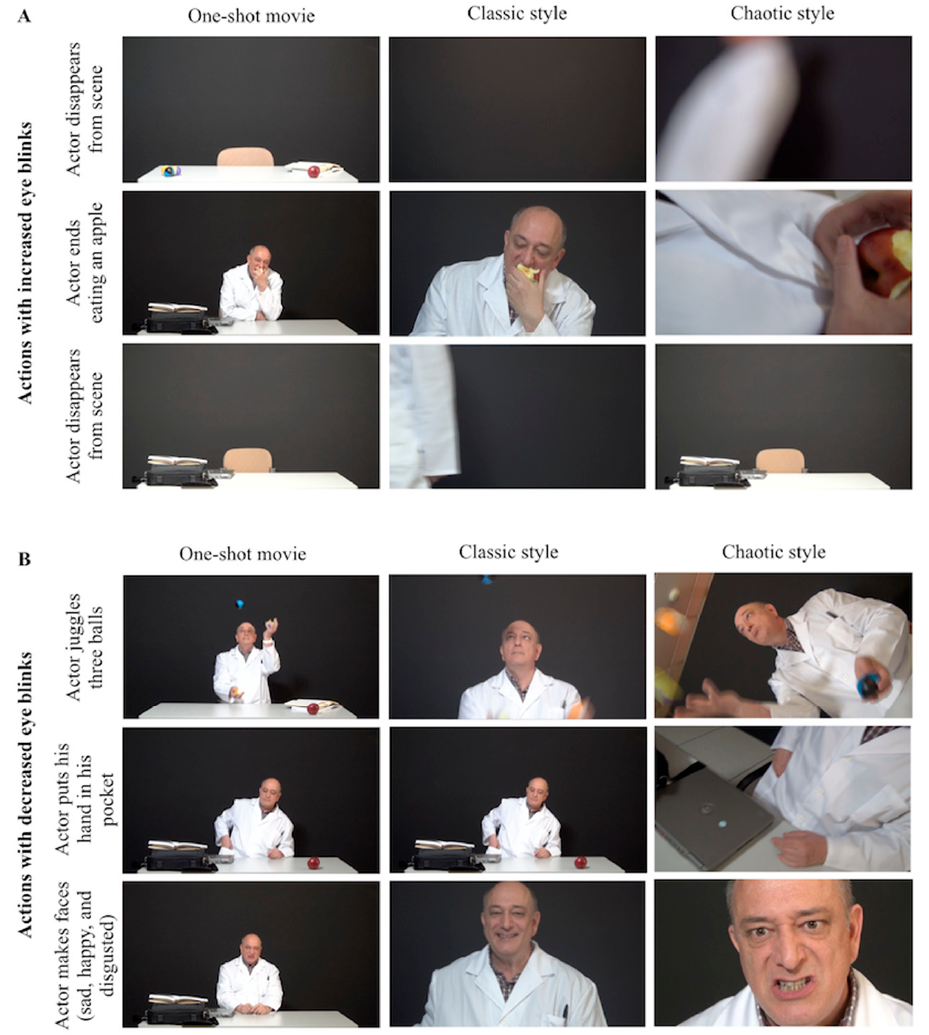
Figure 2. Moments with increased and decreased eye blinks while watching the same narrative with three different styles of editing. ( A ) The three moments when increased eye blinks were observed regardless of the style of editing (from top to bottom): when the actor disappears from the scene near the beginning of the movie, when the actor finishes eating the apple, and when the actor disappears from the scene at the end of the movie. ( B ) The three moments when decreased eye blinks were observed regardless of the style of editing (from top to bottom): when the actor juggles three balls, when the actor puts his hand in his pocket, and when the actor makes faces (sad, happy, and disgusted). The person appearing in Figure 2 is co-author Miguel Á ngel Mart í n-Pascual. Dr. Mart í n-Pascual consents to the appearance of his image in this publication. The mean ( ± SEM) number of eye blinks in the blocks with an increase corresponding to the mentioned actions was 55.89 ( ± 2.18), compared with 29.14 ( ± 1.72) for the bins with a decrease, while for the rest of the bins without an increase or decrease it was 42.03 ( ± 0.67). We compared the mean number of eye blinks during the moments (or